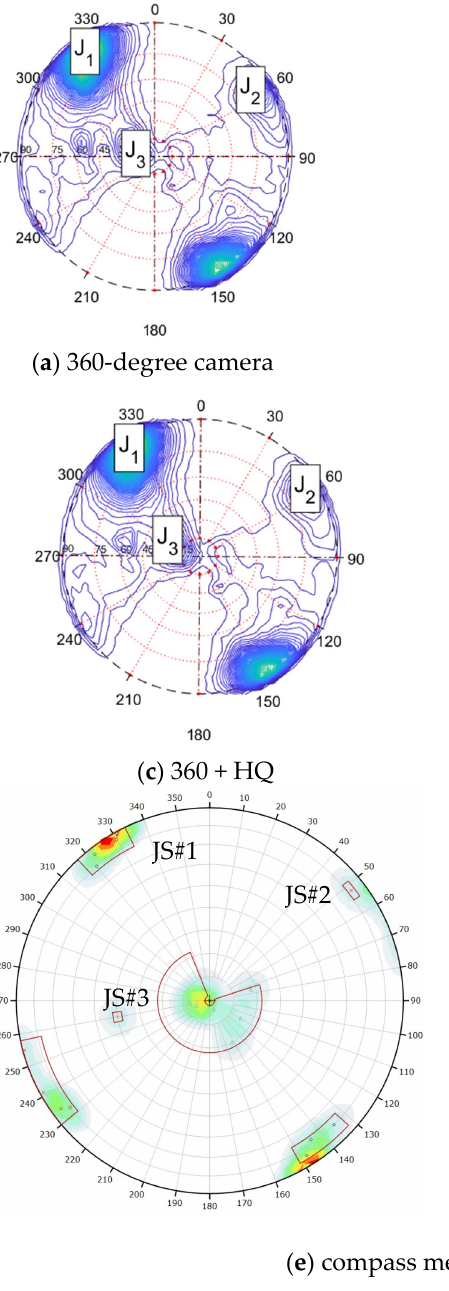
Figure 13. Comparison of the orientation of discontinuity sets extracted from the 3D models using a